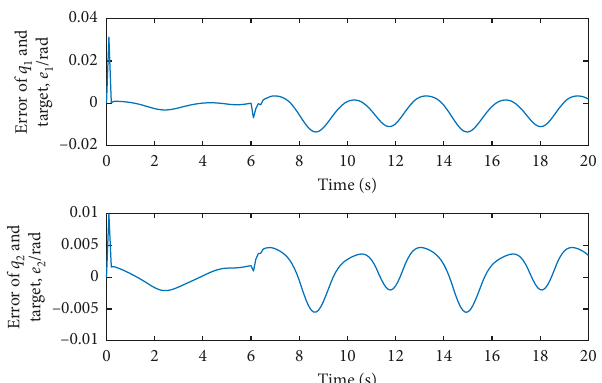
Figure 9: Tracking error under the single NN-based controller with jumping